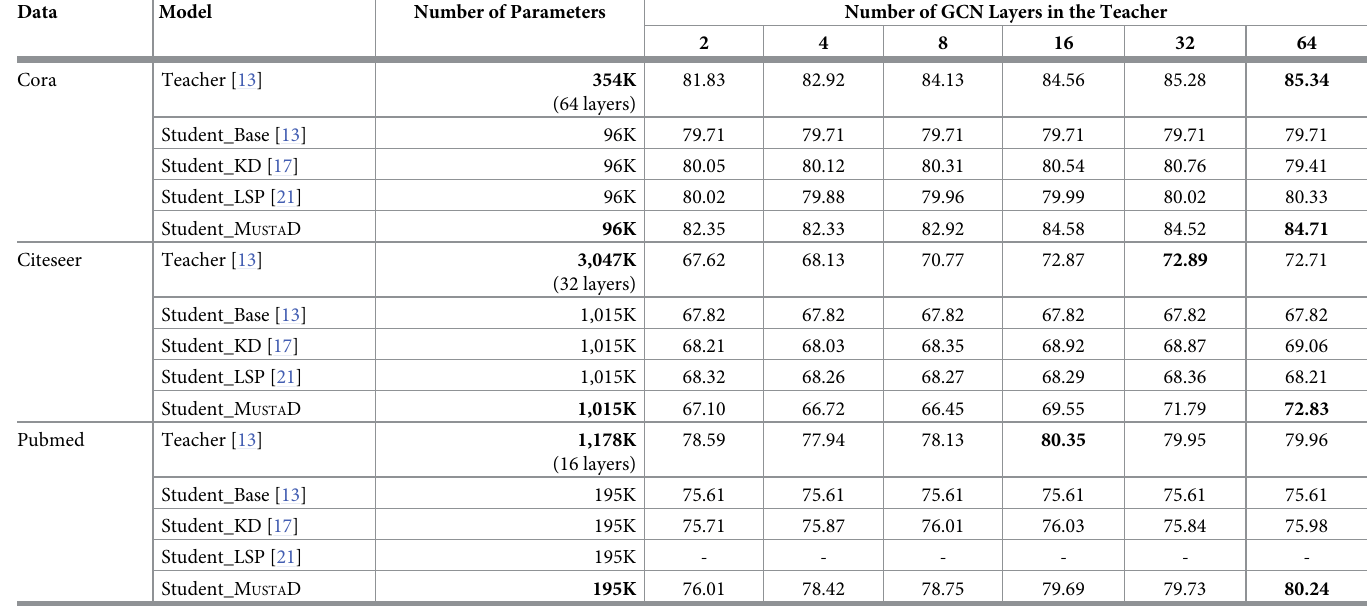
Table 3. Semi-supervised node classification accuracy for Cora, Citeseer, and Pubmed. We perform the distillation from trained teachers with various number of GCN layers: 2, 4, 6, 8, 16, 32, and 64. Student_M USTA D is our distilled student that has the same hidden feature dimension as the teacher. Note that M USTA D consistently outper- forms other KD methods while preserving the multi-hop feature aggregation of the deep